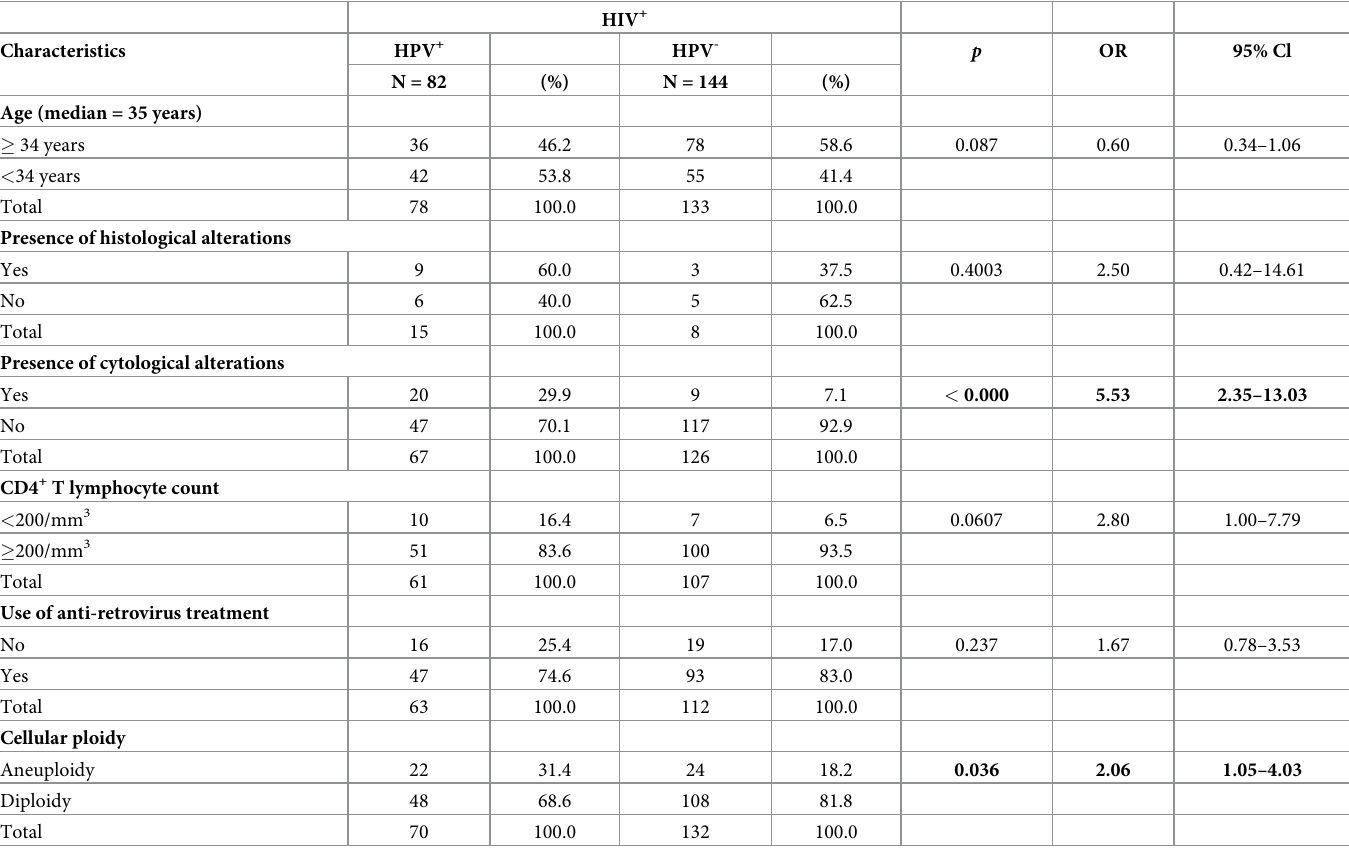
Table 1. Clinical and epidemiological characteristics of HIV-infected women according the HPV co-infection status attending three reference centers for HIV/ AIDS in Recife, northeast of Brazil.